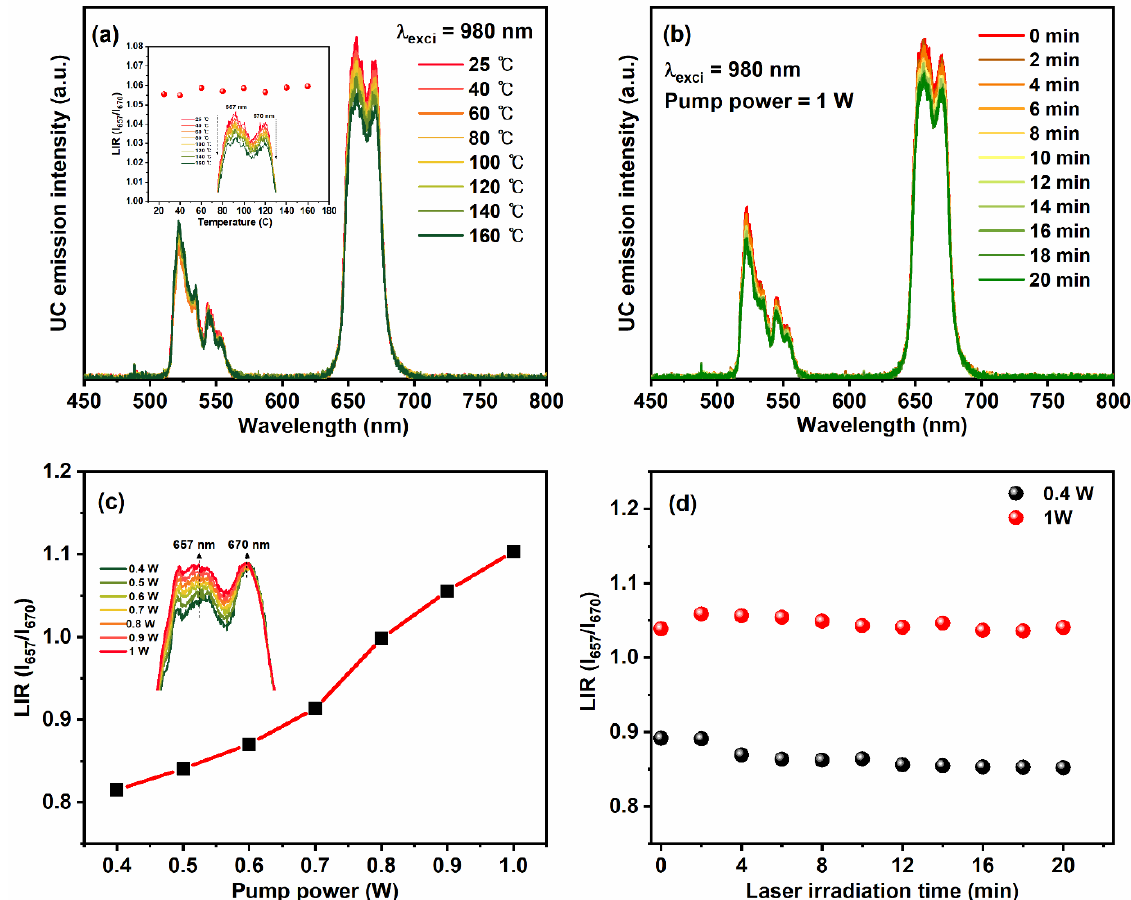
Figure 7. ( a ) Temperature-dependent emission spectra of YVO 4 :Er 3+ /Yb 3+ UC-MHNSPs under 980 nm excitation and the inset displays the corresponding LIR (I 657 /I 670 ) versus temperature plot. ( b ) UC emission spectra of YVO 4 :Er 3+ /Yb 3+ UC-MHNSPs as a series of laser irradiation time, ( c ) a plot of LIR (I 657 /I 670 ) versus incident laser pump power, and ( d ) LIR (I 657 /I 670 ) versus laser irradiation time plots at low and high pump powers.